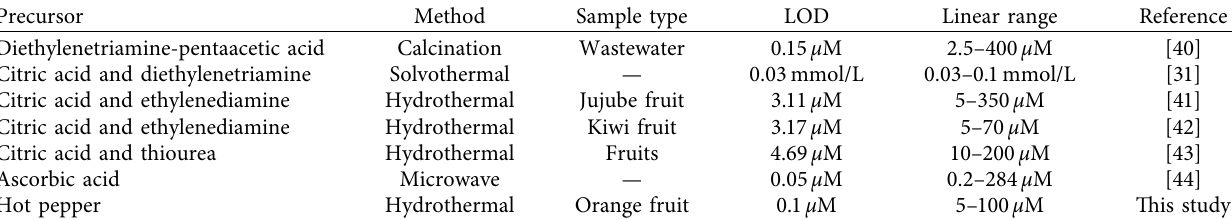
Table 1: Comparison of diferent carbon dots sensors for the determination of ascorbic acid.